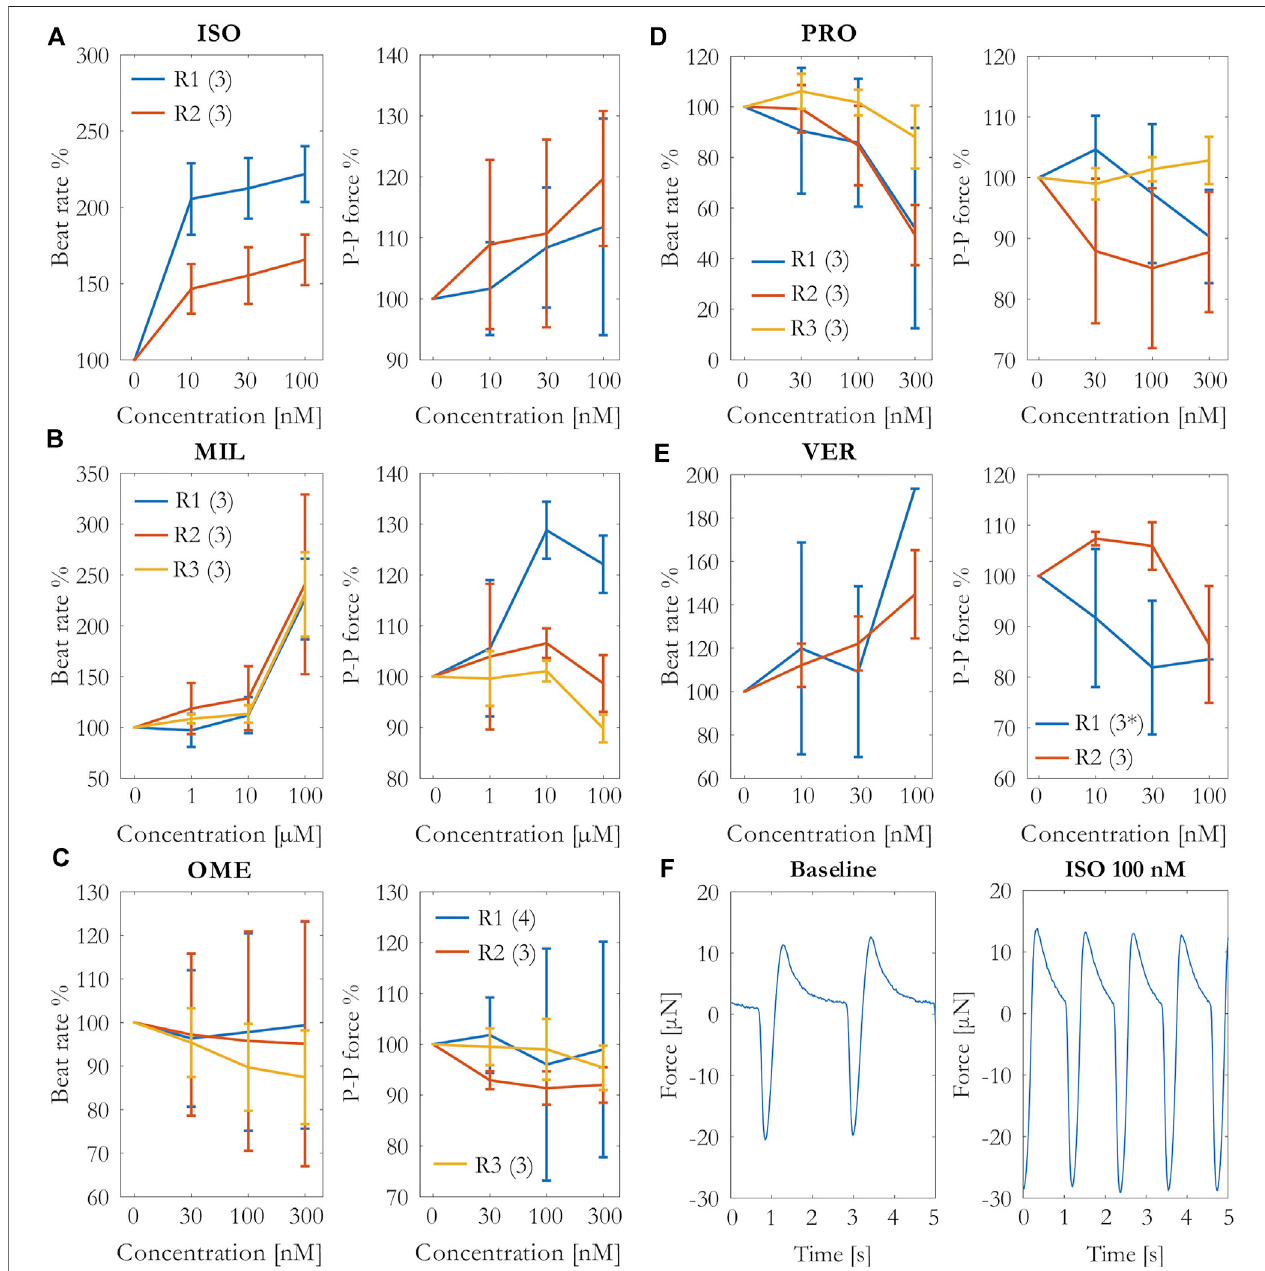
FIGURE3| Percentagechangeofthebeatingrateandforceinthecumulativeconcentrationsof (A) isoprenaline(ISO), (B) milrinone(MIL), (C) omecamtivmecarbil (OME), (D) propranolol (PRO), and (E) verapamil (VER) exposures. Mean and SD of the beating rate and peak-to-peak amplitudes from each repeat R1 – R3 (number of measurements per repeat). *N = 1 at 100 nM. (F) Beating from an example well during baseline and 100 nM isoprenaline force measurements.